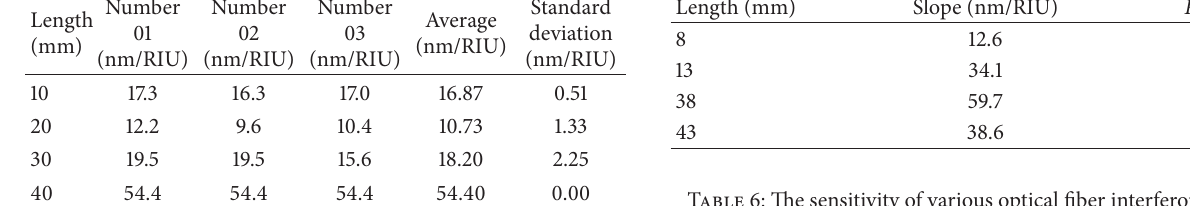
Table 6: The sensitivity of various optical fiber